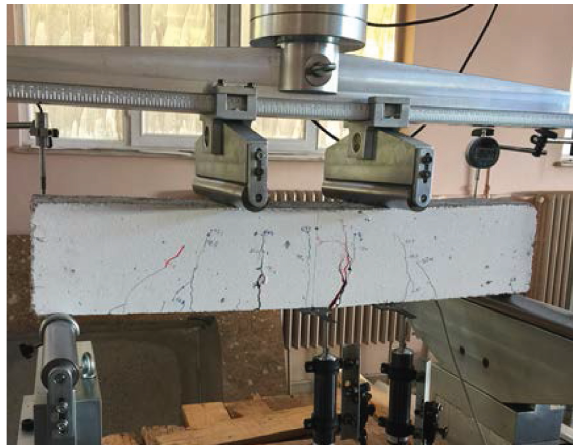
Figure 9: Tested hollow beam under four-point